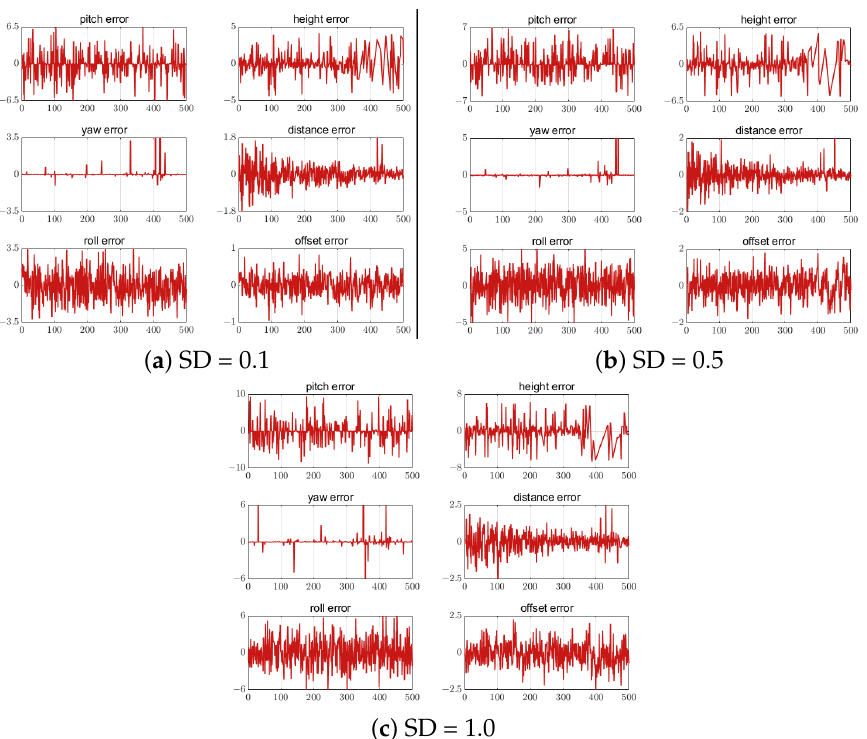
Figure 23. Error of 7 feature points with different SD. The unit of the attitude error is degree. The unit of the position error is meter. The horizontal axis in all figures is the number of measurement